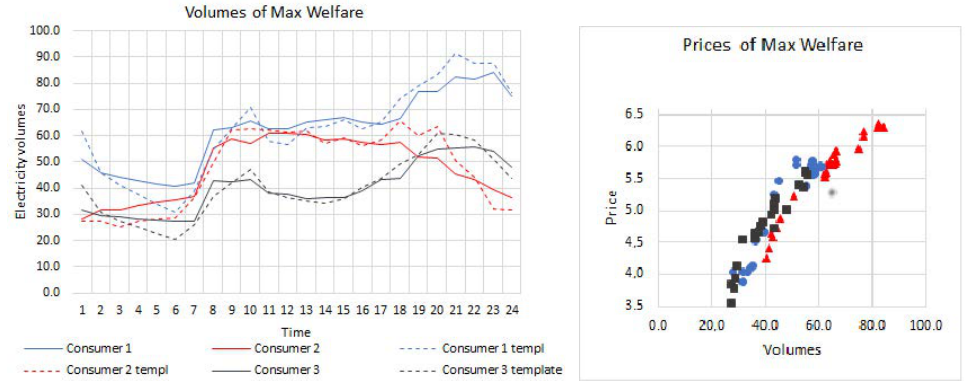
Figure 12. Chart of the load and prices before and after applying maximizing welfare pricing (“Max Welfare”).